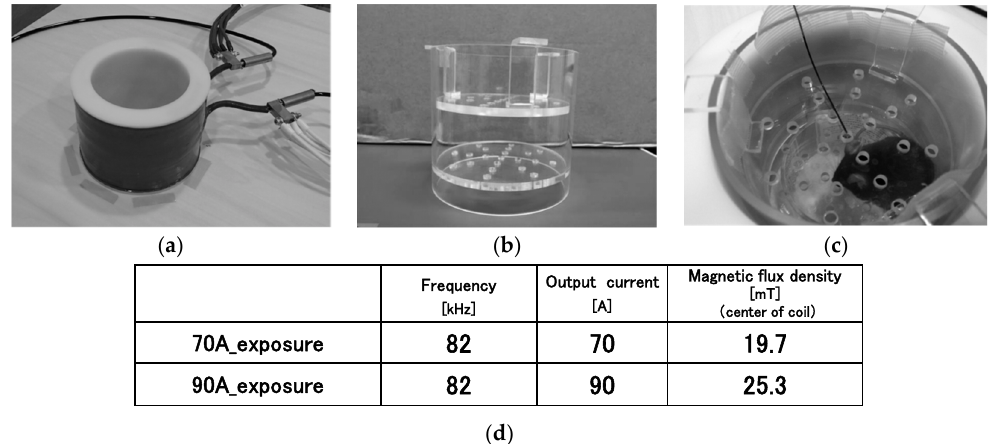
Figure 1. The solenoid coil is shown in ( a ). The acrylic resin holder ( b ) were put into the center space of the coil. A mouse was freely moving in the holder as shown in ( c ). The fiber optic thermometer was set at the top of the acrylic holder containing the mouse. The IF-MF conditions of 70A_exposure and 90A_exposure are shown in ( d ).